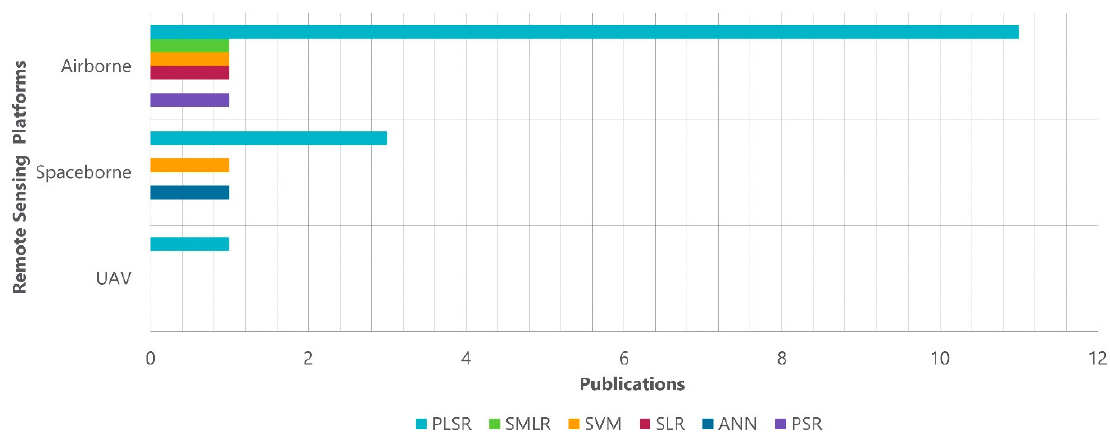
Figure 4. Number of articles which used specific multivariate calibration technique (PLSR: Partial Least Squares Regression; SMLR: Stepwise Multiple Linear Regression; SVM: Support Vector Machines; SLR: Simple Linear Regression; ANN: Artificial Neural Networks; PSR: Penalized-spline Signal Regression; MLR: Multiple Linear Regression) in each EO